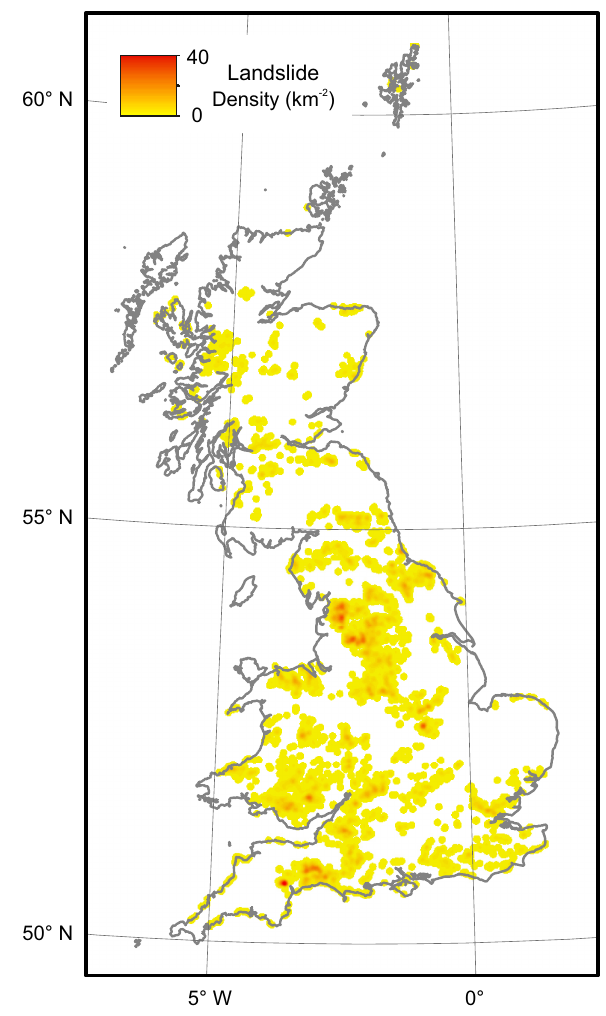
Figure 6. Map of landslide density (number of landslides per km 2 ) across the UK derived from mapped landslide deposits. Data is grid- ded to 1km and calculated using a 5km search radius. Low land- slide densities in Scotland and NE Wakes may indicate that cover- age is particularly